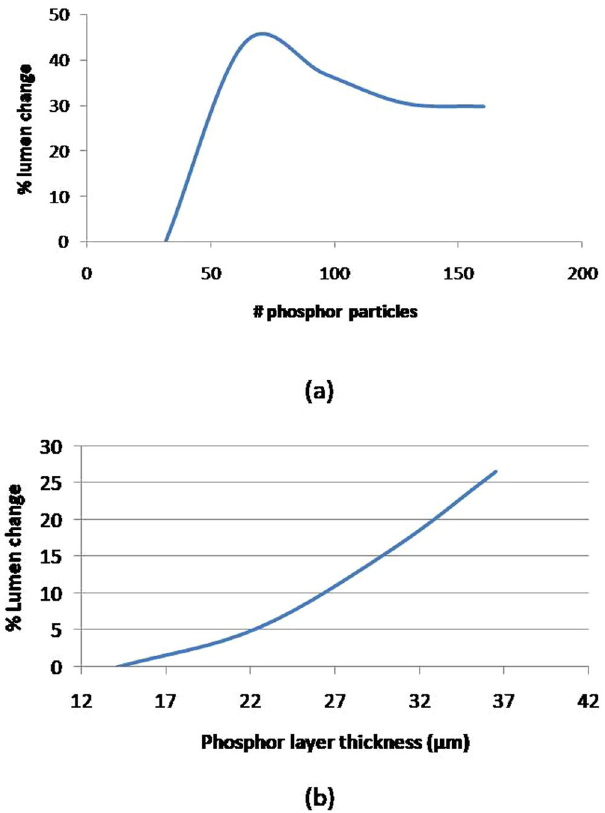
Figure 10. TracePro simulation results. ( a ) % Lumens change due to different amount of phosphor particles with 32 phosphors particles as reference. ( b ) % Lumen change due to increasing phosphor layer thickness while the number of phosphor particles is kept at 64.